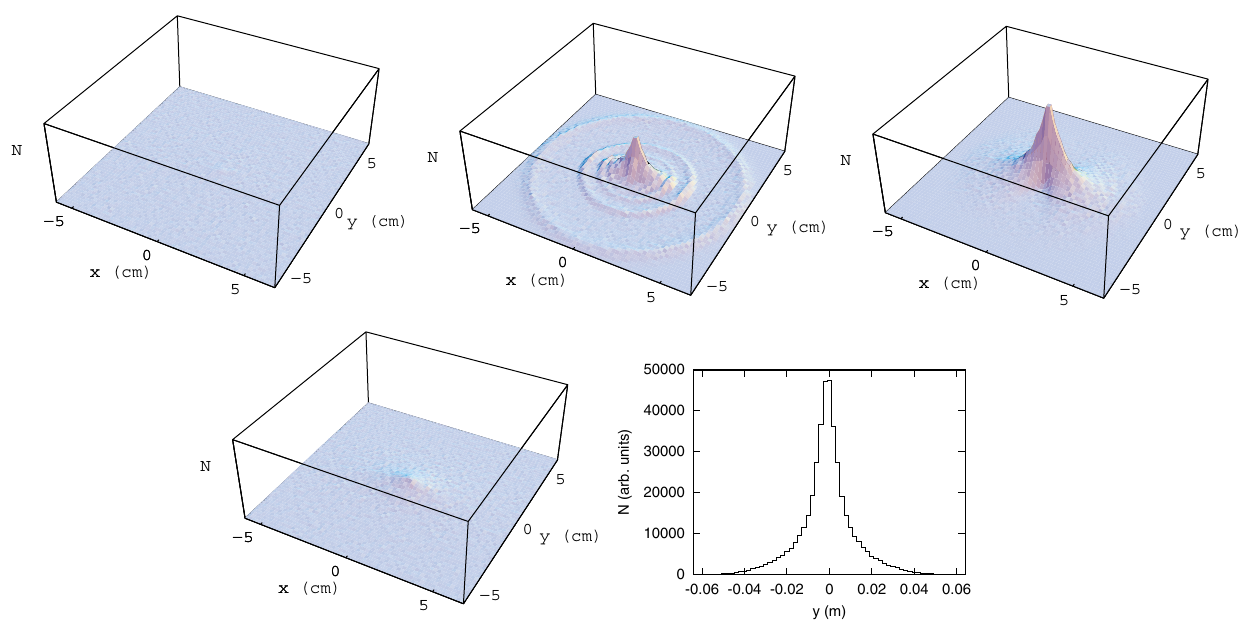
FIG. 3. (Color) Transverse electron distribution during the passage of the last (10th) bunch: (1st) 0 m; (2nd) 10 m; (3rd) 50 m; (4th) 100 m; and (5th) vertical distribution after 50 m passage. The electron density, N , is plotted with arbitrary units in the 1st to 4th